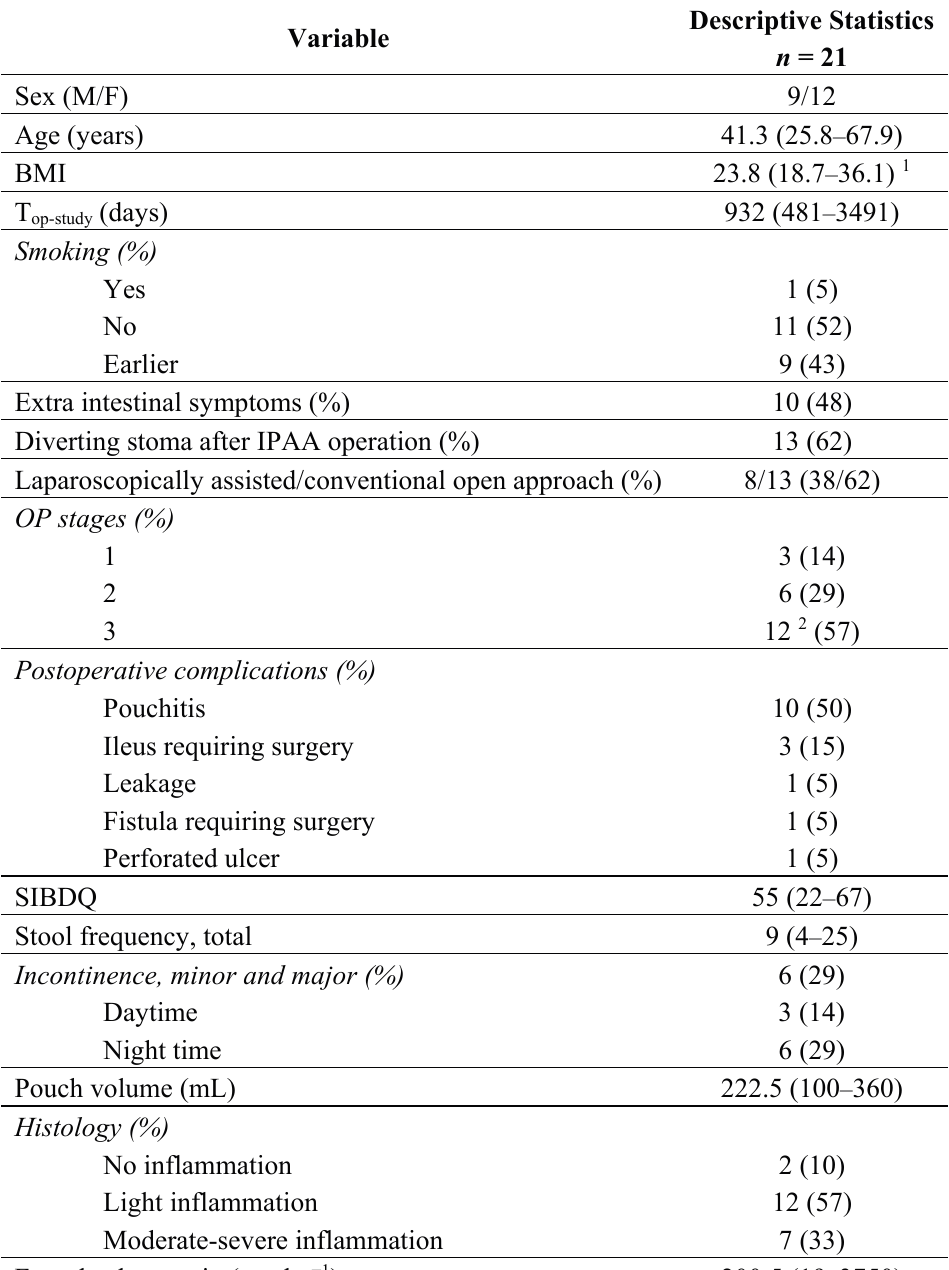
Table 1. Patient characteristics and baseline